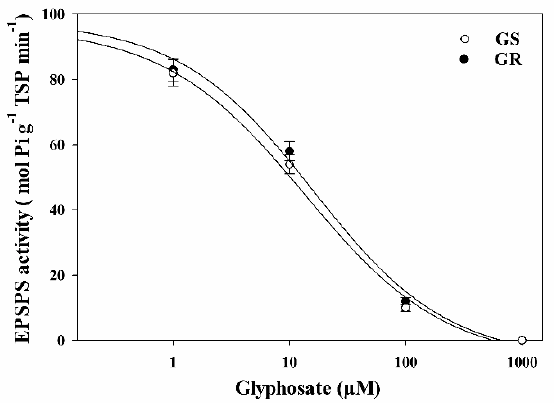
Figure 4. Dose–response curves of the EPSPS enzyme activity of C. distichophylla plants exposed to different glyphosate concentrations (µM), expressed as a percentage of the untreated control ( n = 3).